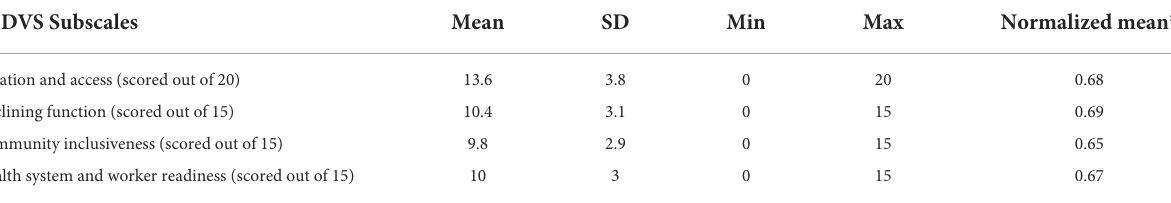
TABLE 3 Absolute and comparative scores on 4 PADVS subscales addressing issues associated with age-related and societal vulnerability to